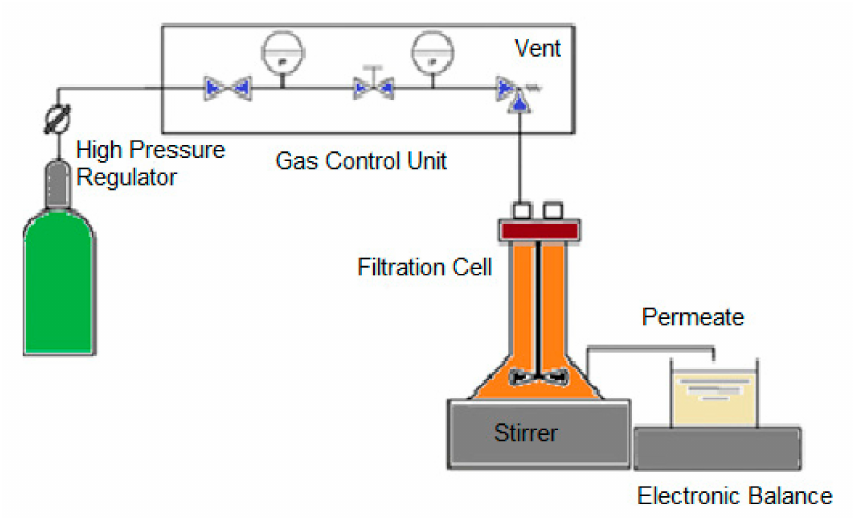
Figure 2. Scheme of the membrane processing used in this work to purify the biopeptides from codfish blood and sardine cooking